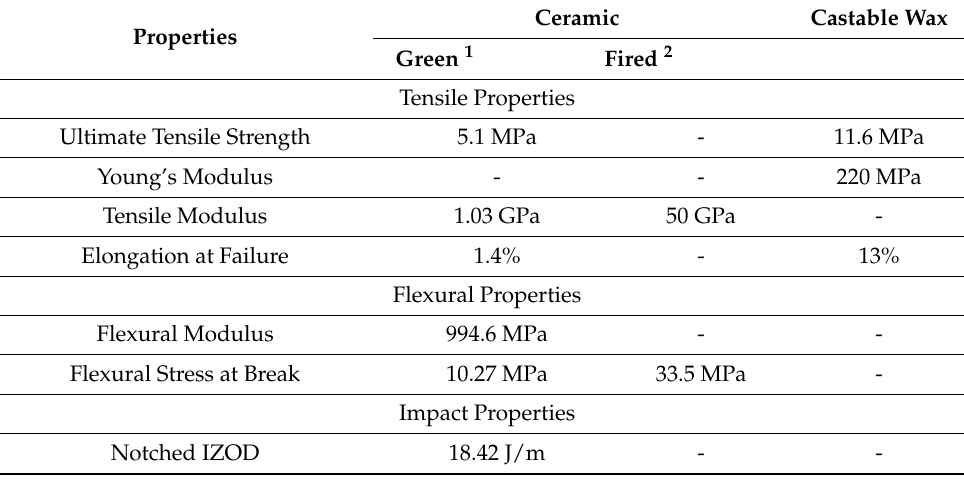
Table 5. Mechanical properties of ceramic and castable wax resins